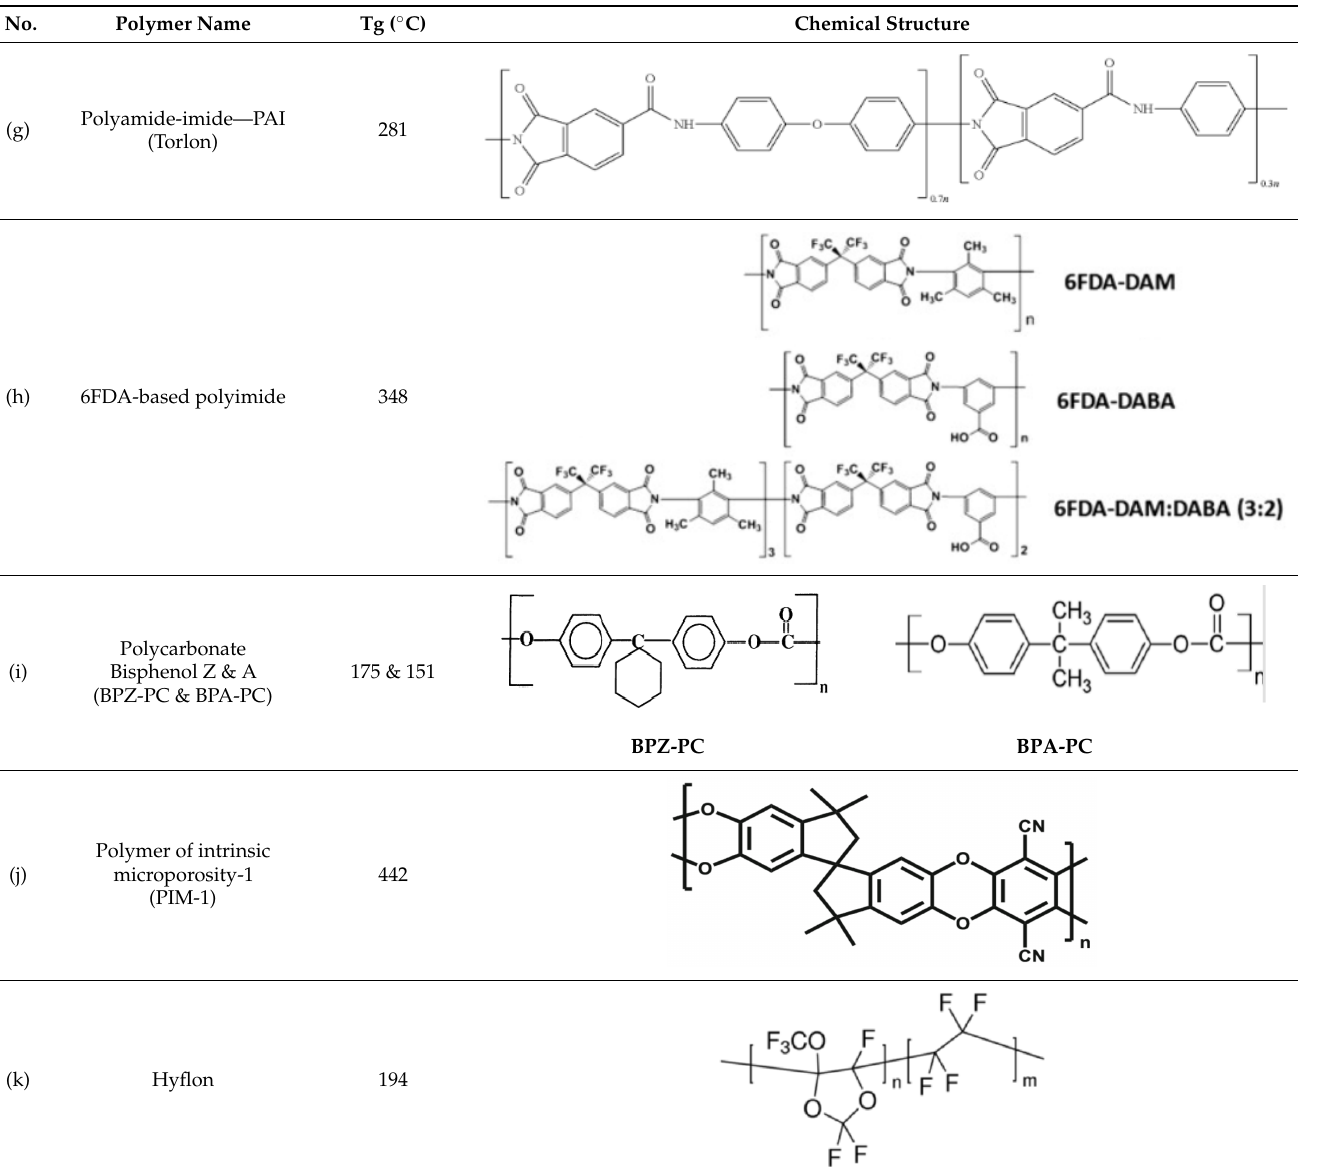
Figure 1. CA membrane performance trend for CO 2 /CH 4 mixed gas [47]. CO 2 plasticization pressure of CA is not changed with different degrees of acetyla- tion. Sanders et al. [23] mentioned that CO 2 changes the structure of the more highly acet- ylated membrane more significantly, as shown in hysteresis studies, due to the higher CO 2 solubility. Compared to the hydroxyl–hydroxyl, the intermolecular network that grips the